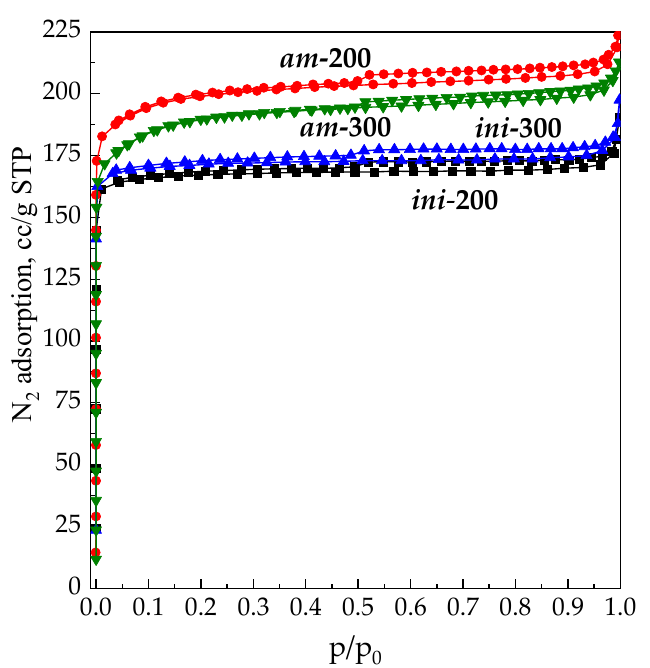
Materials 2023 , 16 , x FOR PEER REVIEW Figure 3. N 2 ( − 196 °C) adsorption isotherms on the samples ini- 200 / ini- 300 and am- 200 / am- 300 . Figure 3. N 2 ( − 196 ◦ C) adsorption isotherms on the samples ini -200 / ini -300 and am -200 / am -300 .